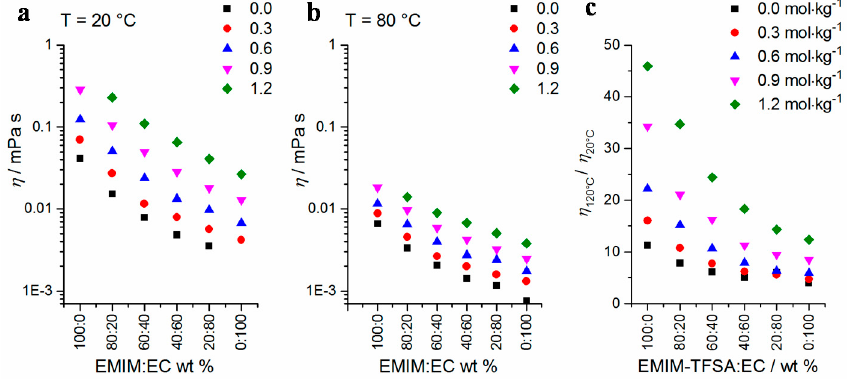
Figure 6. Viscosity of the ternary mixtures at two selected temperatures (( a ) 20 °C; ( b ) 80 °C); In ( c ), the temperature dependency is shown by the quotient of η 120°C and η 20°C .